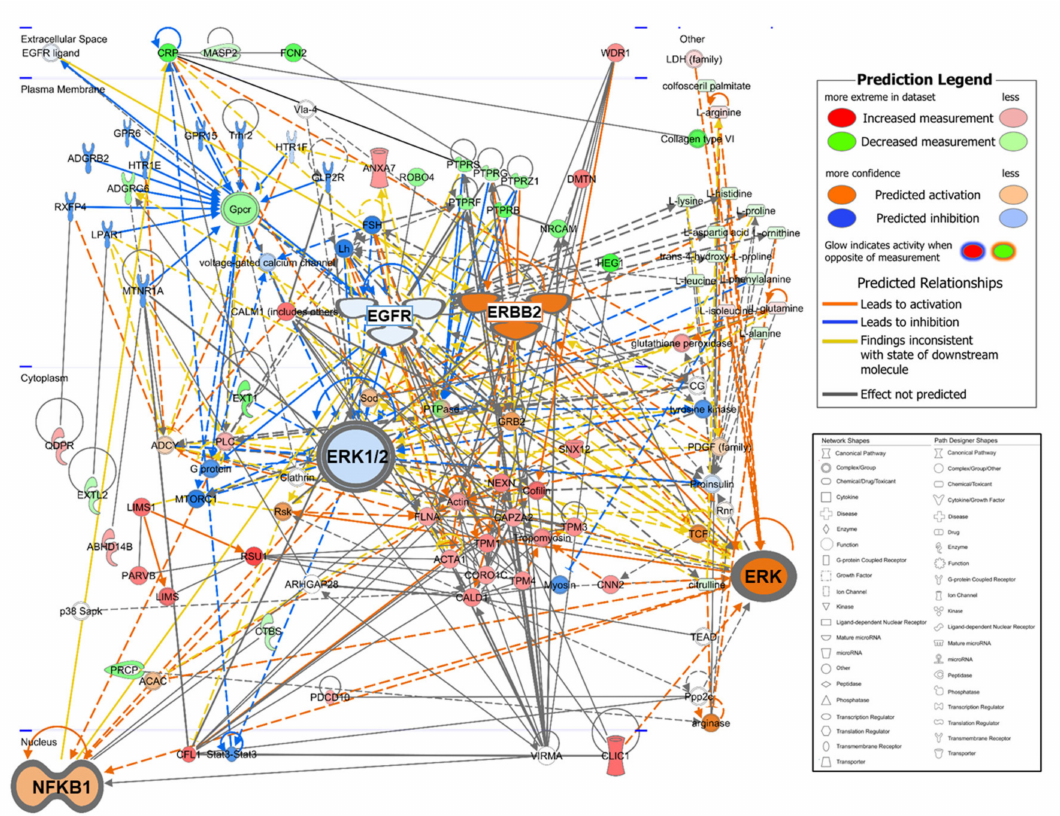
Figure 3. Merging network associated with the EGFR / ERBB2 signaling pathway by IPA-identified three networks (#1, #5, and #12 in Table S6). EGFR and ERK1 / 2 are weakly downregulated, and NFKB1 and ERBB2 are strongly upregulated in ovarian cancer patients. The network shapes show the categories of the proteins. In the IPA network, red indicates ovarian cancer upregulation, green, downregulation, orange, predicted upregulation, and blue, predicted downregulation and the color intensity indicates the magnitude of the relative change in protein